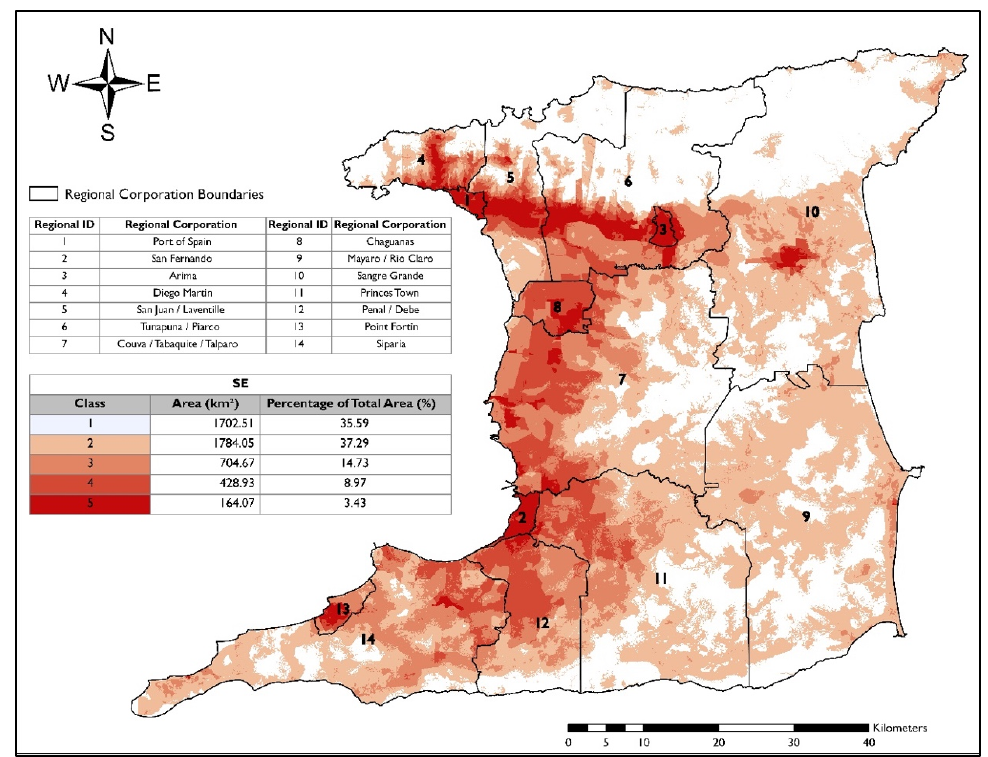
Figure 14. Risk assessments created for FR.